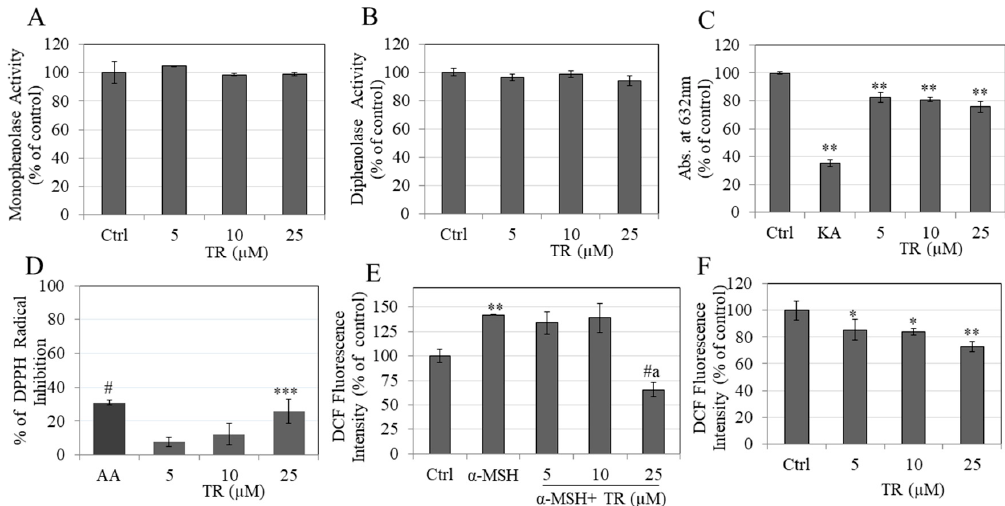
Figure 4. Mushroom tyrosinase activity assay was conducted with different concentrations of TR (0–25 µM) using ( A ) L-TYR substrate; monophenolase activity and; ( B ) L-DOPA substrate; diphenolase activity; ( C ) Copper chelation activity measured by reduction in absorbance at 632 nm; ( D ) % DPPH radical scavenging assay with ascorbic acid (AA) at 2.5 µg/mL as a positive control; Intracellular ROS estimated in ( E ) α -MSH stimulated; and ( F ) basal conditions in B16F10 cells treated with different concentrations of TR; One-way ANOVA with Dunnett’s test; * p < 0.05; ** p < 0.01; *** p < 0.001; # p < 0.0001; letter a - p < 0.0001 vs. α -MSH +TR-10 µM; All Data are Mean ± SD